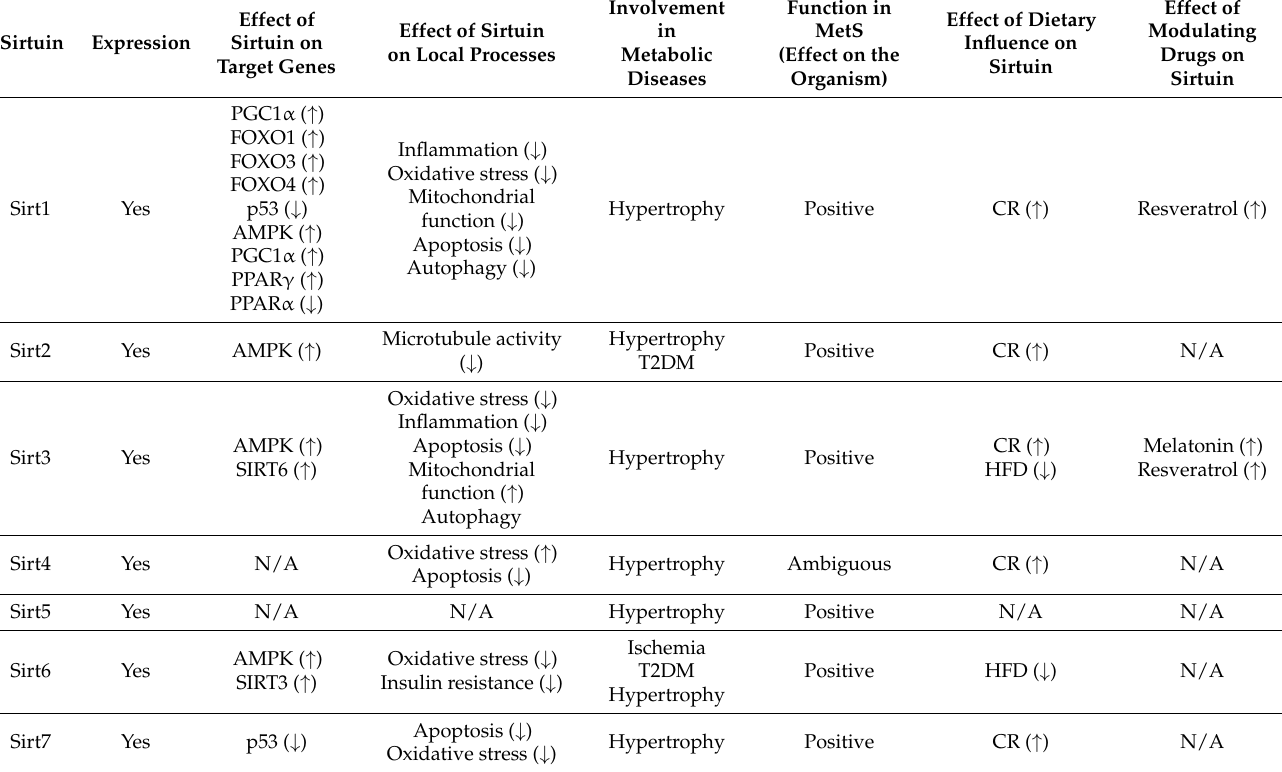
Table 6. Overview of the role of Sirtuins in the